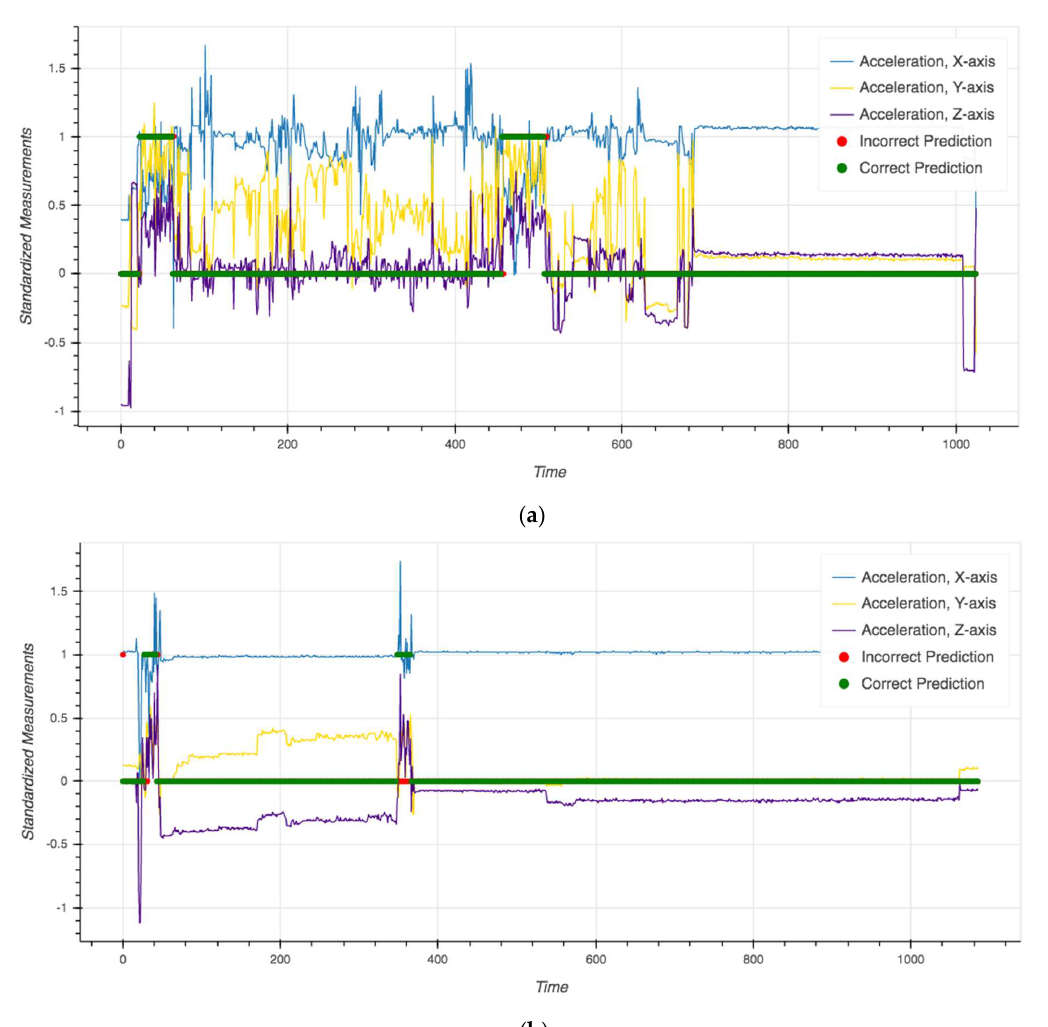
Figure 1. Model predictions and “ground truth” activities over time for the best performing LOSO fold ( a ) and worst performing LOSO fold ( b ). Green areas indicate a correct prediction and red areas indicate a misclassification. Each time unit on the X-axis represents a sliding window of six 30-second readings, with 50% overlap, that was used in the analysis.